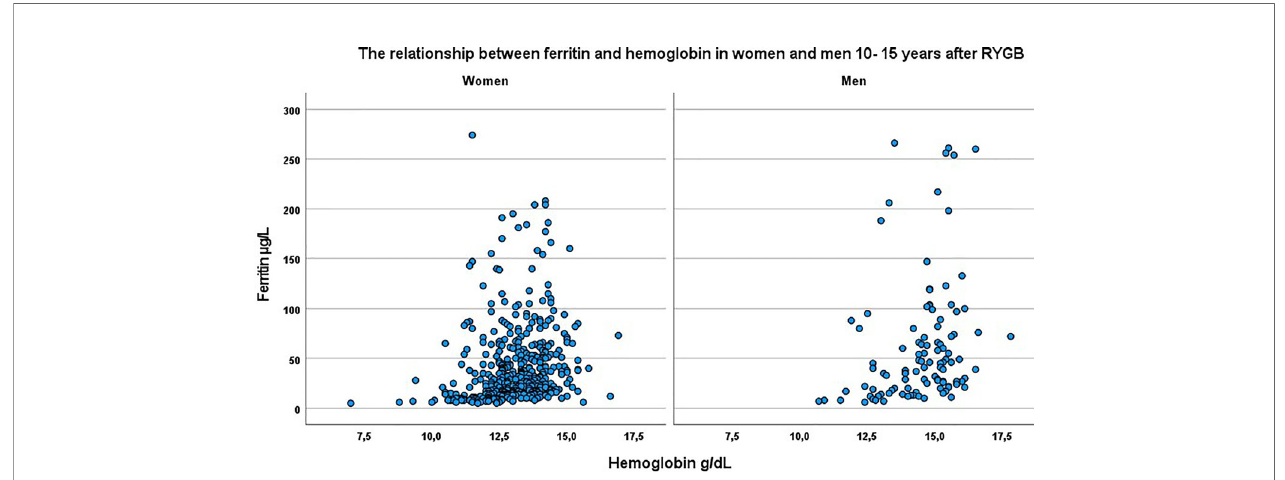
FIGURE 1 | The relationship between ferritin and hemoglobin in women and men 10-15 years after